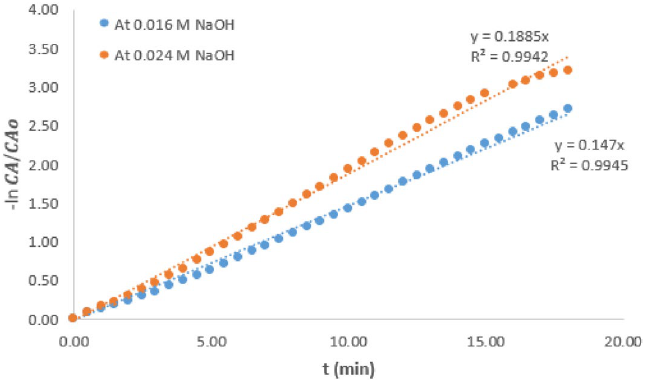
C A Figure 6. − ln C Ao vs time graph for hydrolysis of CV at 6 °C and variable concentration of NaOH.